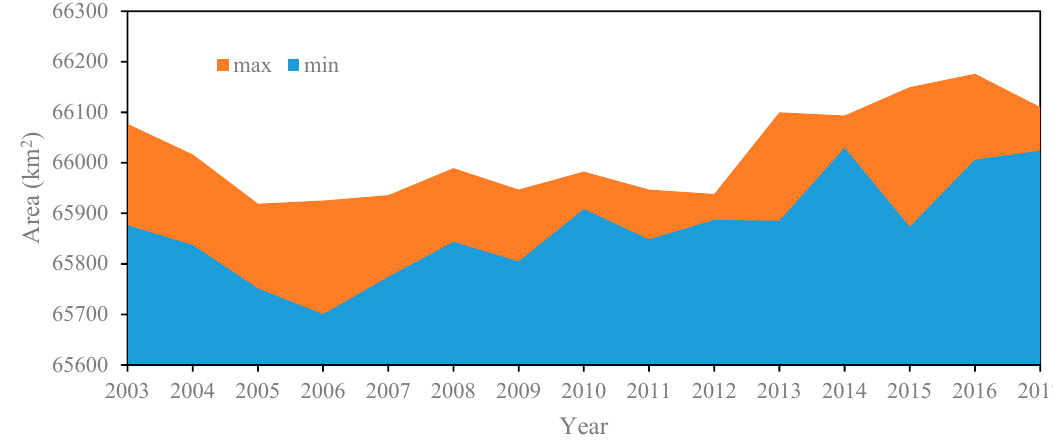
Figure 7. Comparison of the maximum and minimum areas of every year from 2003 to 2017 extracted from available data.